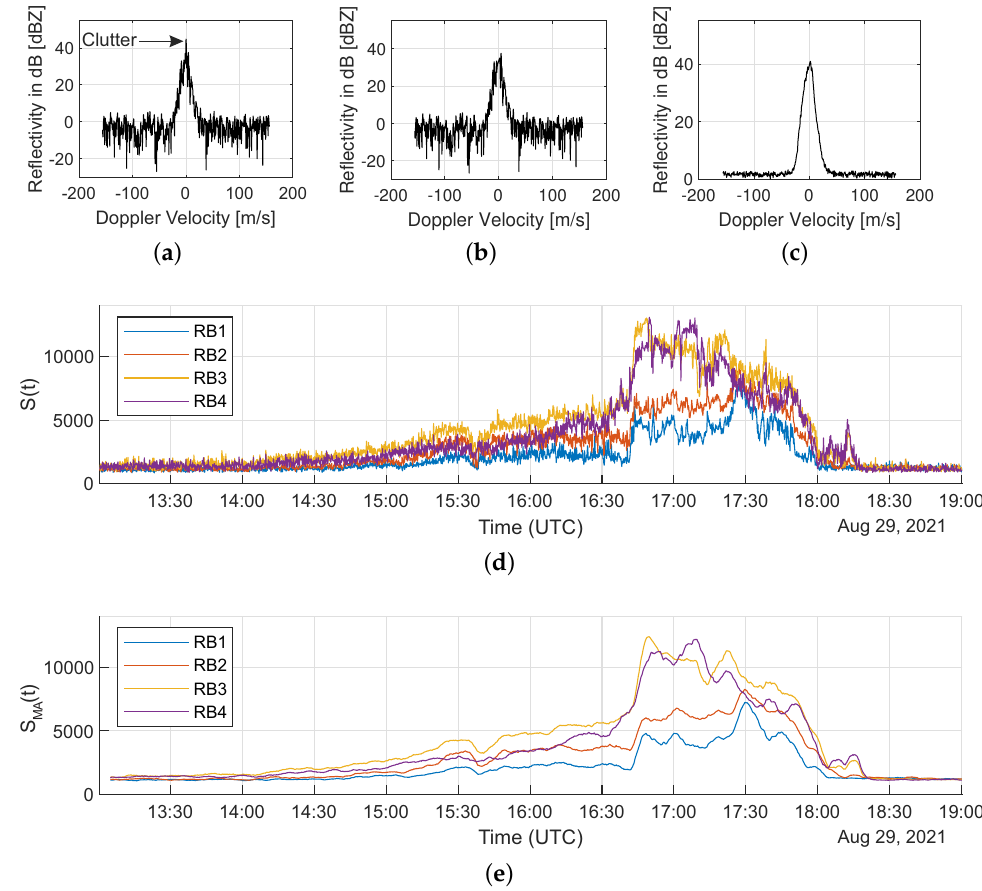
Figure 2. Different stages of the processing flow applied to VAPORS-S data. The clutter, which affects the original Doppler spectrum ( a ), is removed and replaced by linearly interpolating adjacent values ( b ). Subsequently, a single Doppler spectrum ( c ) is produced by averaging 100 spectra, so as to noticeably increase the signal-to-noise ratio. A time series ( d ) is then produced by plotting the sum of the dBZ values within the whole Doppler velocity range for every averaged spectrum and each range bin (RB 1: 2850–3000 m; RB 2: 3000–3150 m; RB 3: 3150–3300 m; RB 4: 3300–3450 m). Finally, a smoother time series ( e ) is calculated from ( d ) using a moving average with a 5 min window (see text for further